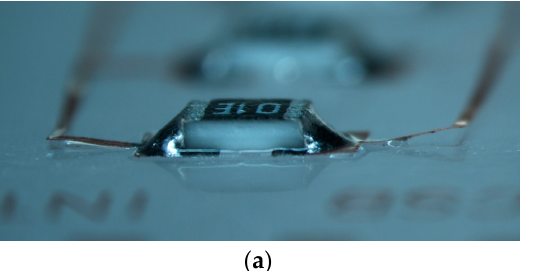
Figure 13. Cracks in ear mold substrate after reflow soldering with 180 °C peak temperature ( a ). Figure 14. Soldering of 0603 SMD with SnBi solder at 180°C on aerosol jet printed Ag structures Close-in view of crack through conductor path ( b ). after electroless copper plating (substrate: Luxaprint 3D mold). Plating time 60 min ( a ) and 15 min